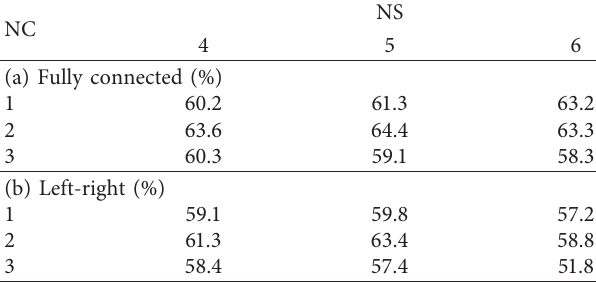
Table 1: Automatic classification results of different HMM structures (features of timbre only).